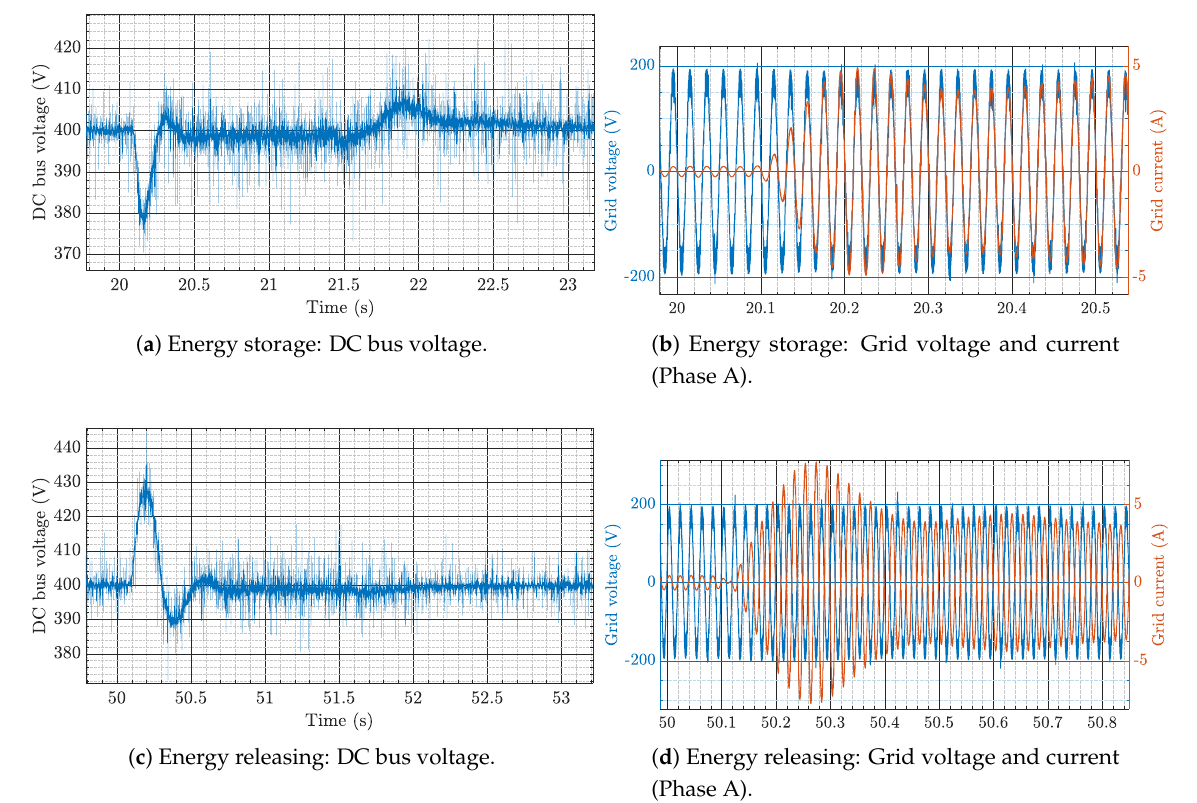
Figure 14. Grid-side converter experimental results (zoom).